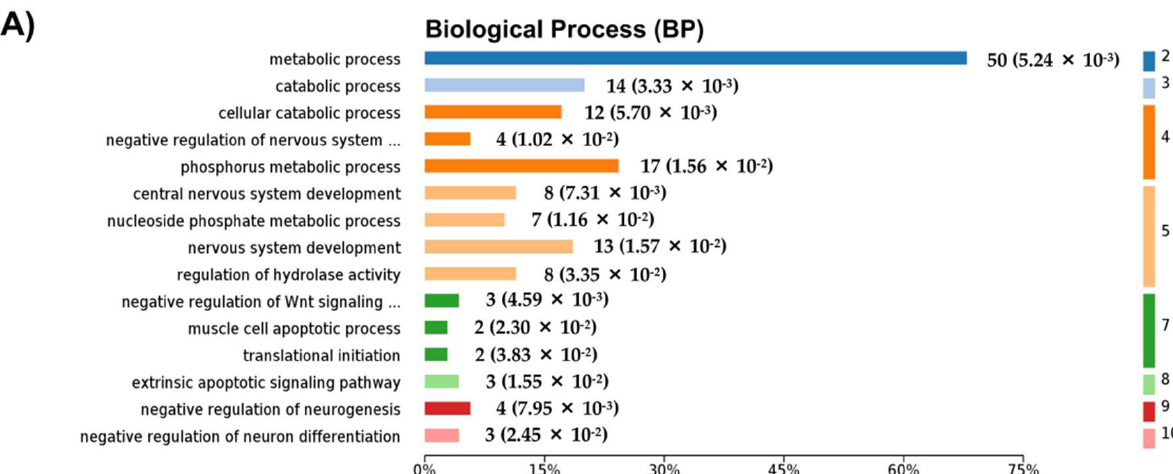
D ) PPI of DEPs involved in mitochondrion organization, negative regulation of apoptotic process, synapse, and neuron part, respectively. ↑ , upregulated; ↓ , downregulated.